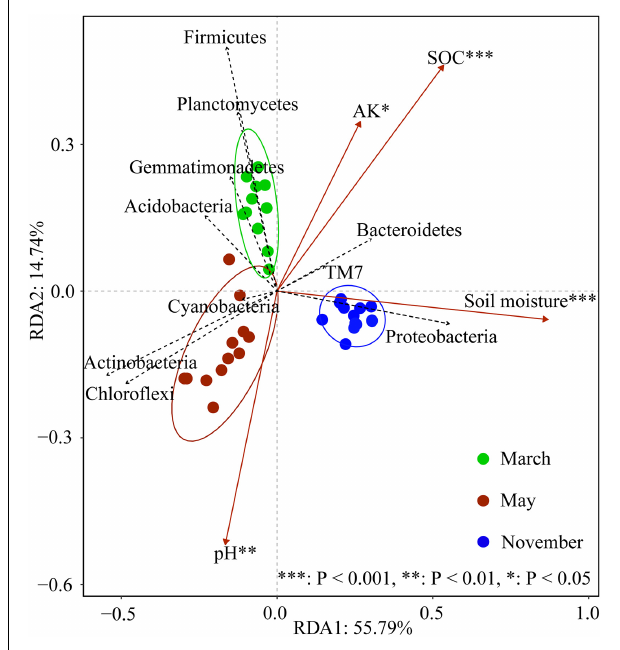
FIGURE 4 | Principal coordinate analysis (PCoA) based on Bray-Curtis distances of soil bacterial community compositions at the OTU level in three sampling months.